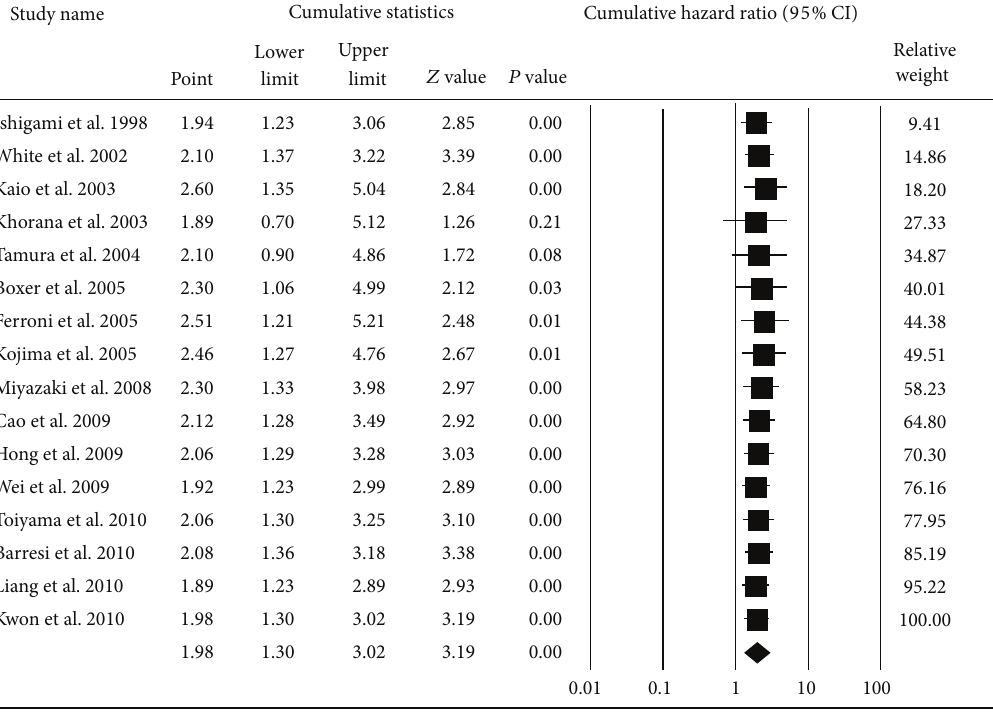
Figure 4: Cumulative meta-analysis for the association between VEGF expression and overall survival of CRC.